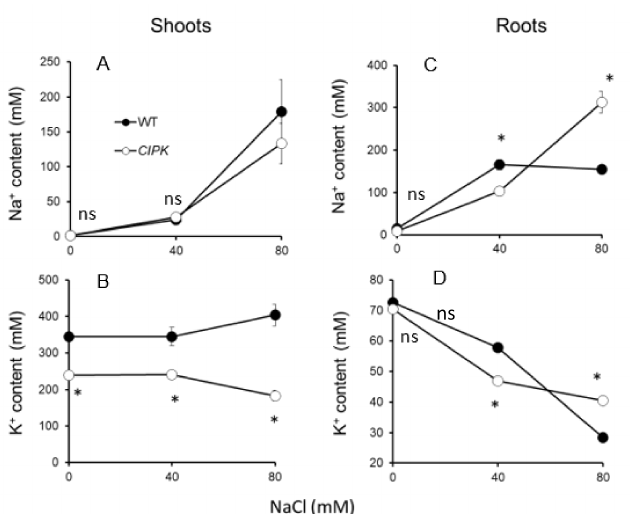
Figure 2. Effect of salinity on plant ionic composition. ( A ) shoot Na + content, ( B ) shoot K + content; ( C ) root Na + content; and ( D ) root K + content. Plants of both lines were grown in a hydroponic system for 21 days under three NaCl levels (0, 40, and 80 mM NaCl). Closed circles—WT; open circles— Oscipk9 mutant line. Data are the mean ± SE ( n = 6). Asterisk denotes significant difference between WT and cipk9 plants at p < 0.05.